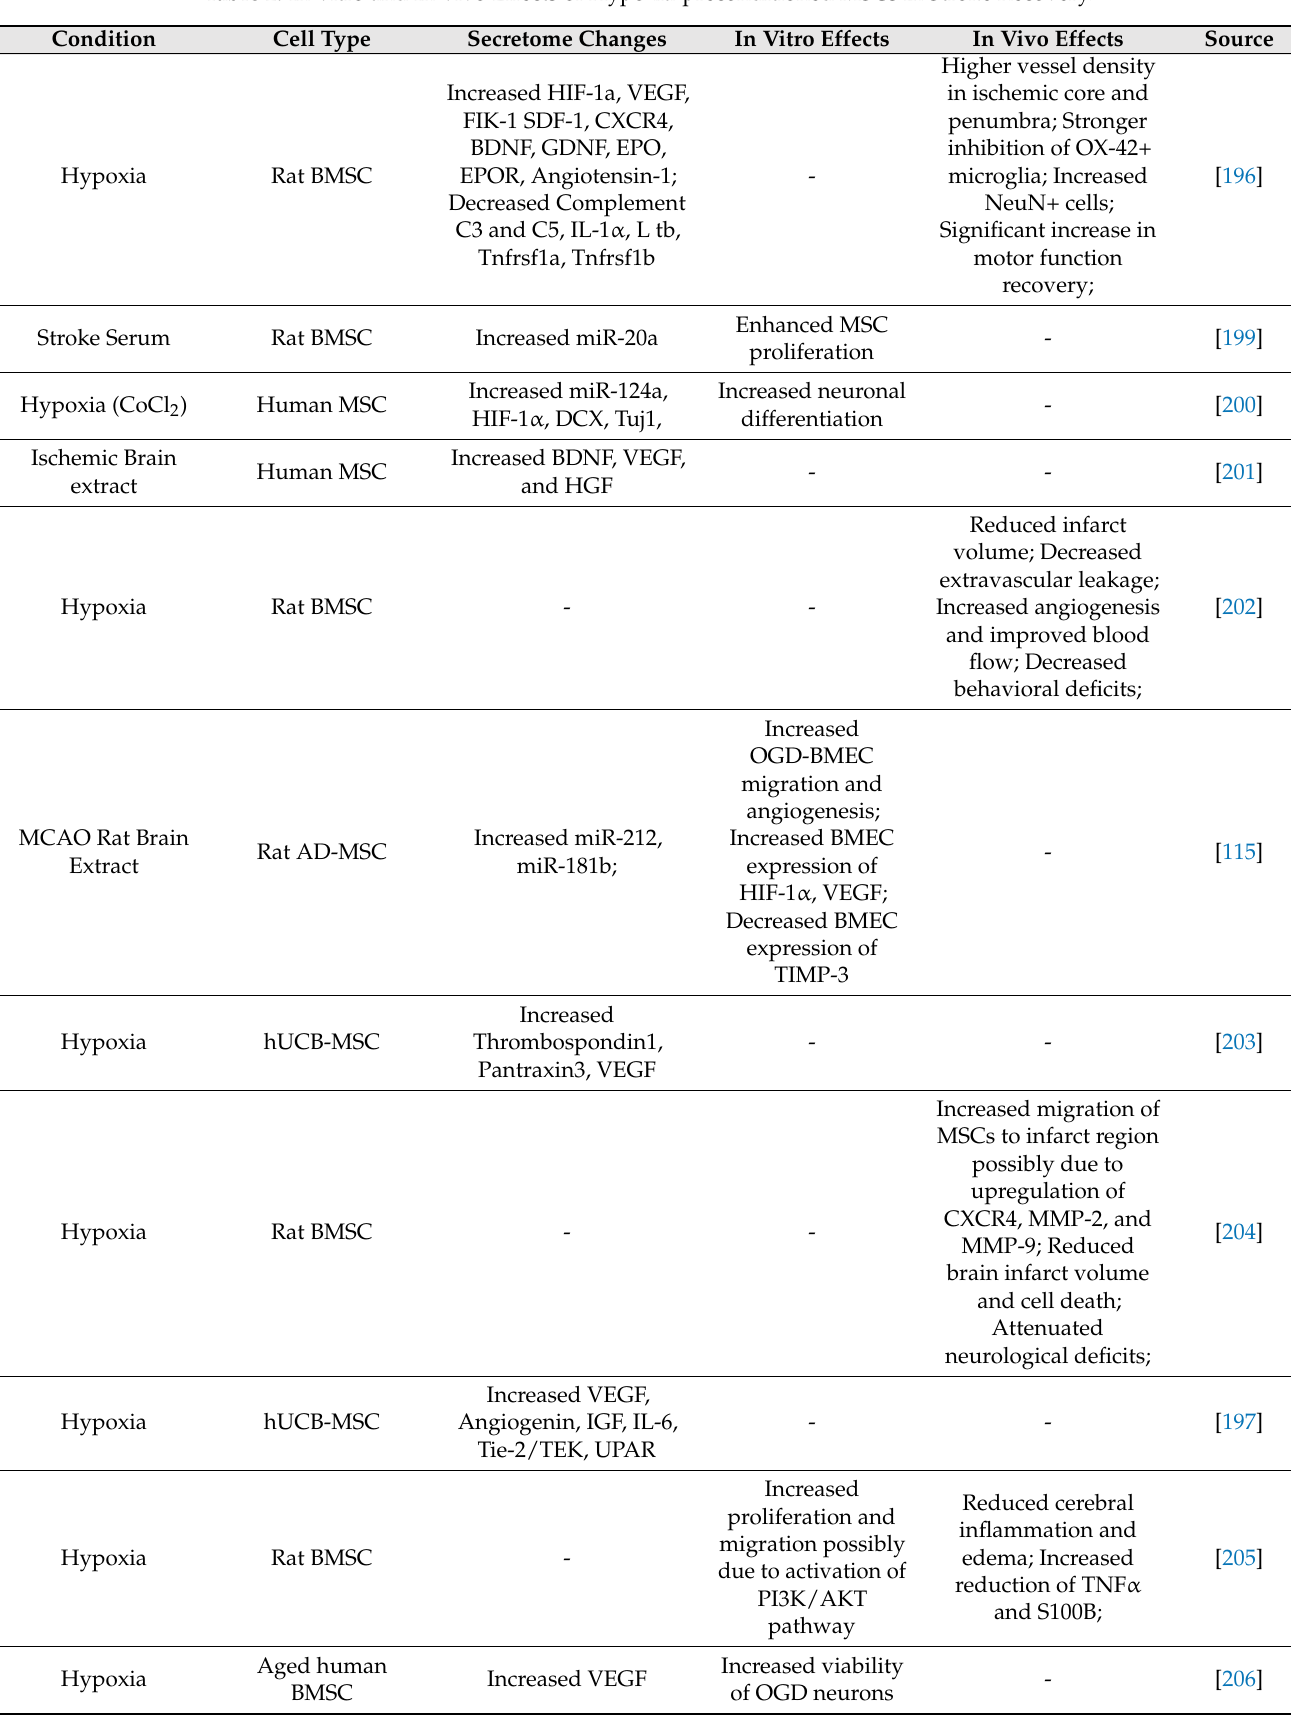
Table 2. In Vitro and In Vivo Effects of Hypoxia-preconditioned MSCs in Stroke